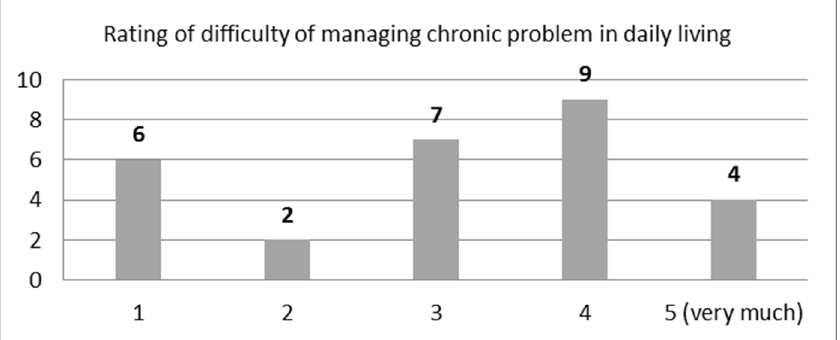
Figure 2. Distribution of rating scores for difficulty in managing chronic illness in daily life (answers from 28 participants who answered that they have a chronic illness).